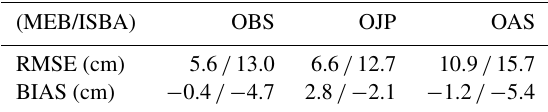
Table 8. The RMSE and BIAS for the ISBA-MEB and ISBA exper- iments for snow depth calculated using half-hourly values for which snow is present in the